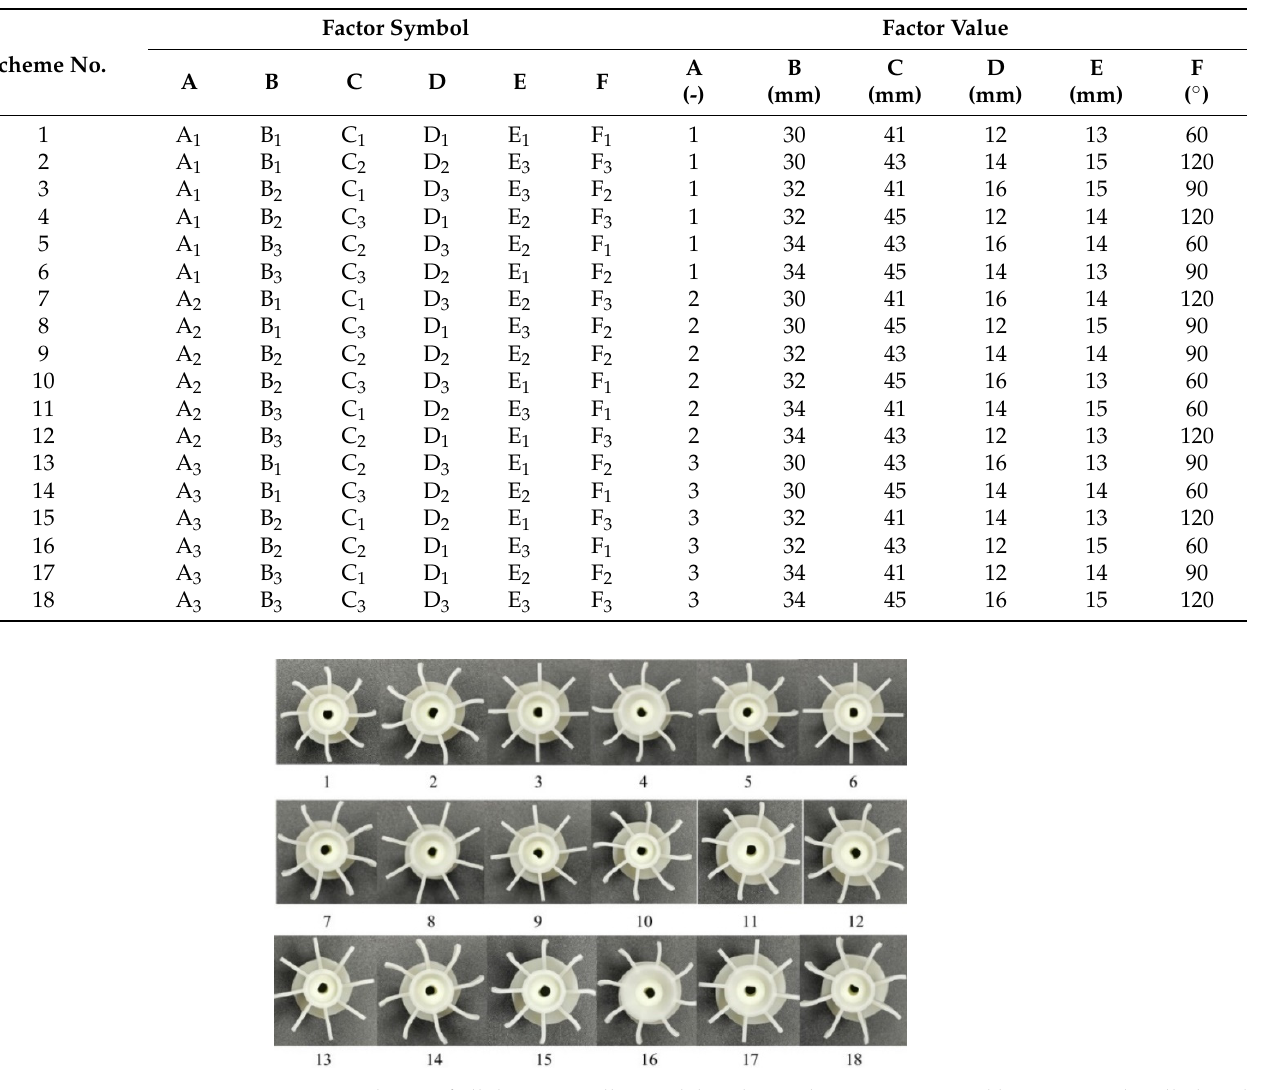
Figure 5. Photos of all the 18 impeller models, where schemes represented by 1~18 are detailly listed in Table 2.